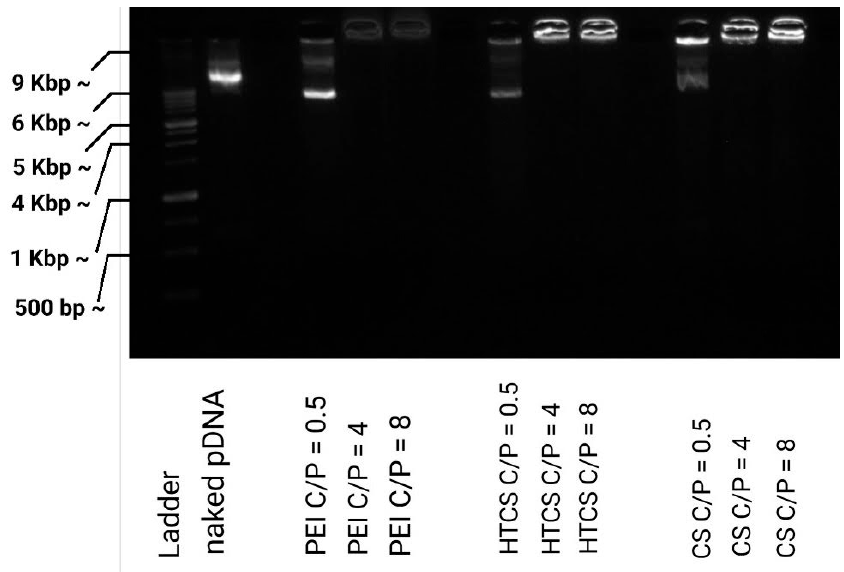
Figure 4. Plasmid DNA binding affinity of PEI, CS, and HTCS determined by gel retardation assay at C/P ratios of 0.5:1, 4:1, and 8:1.